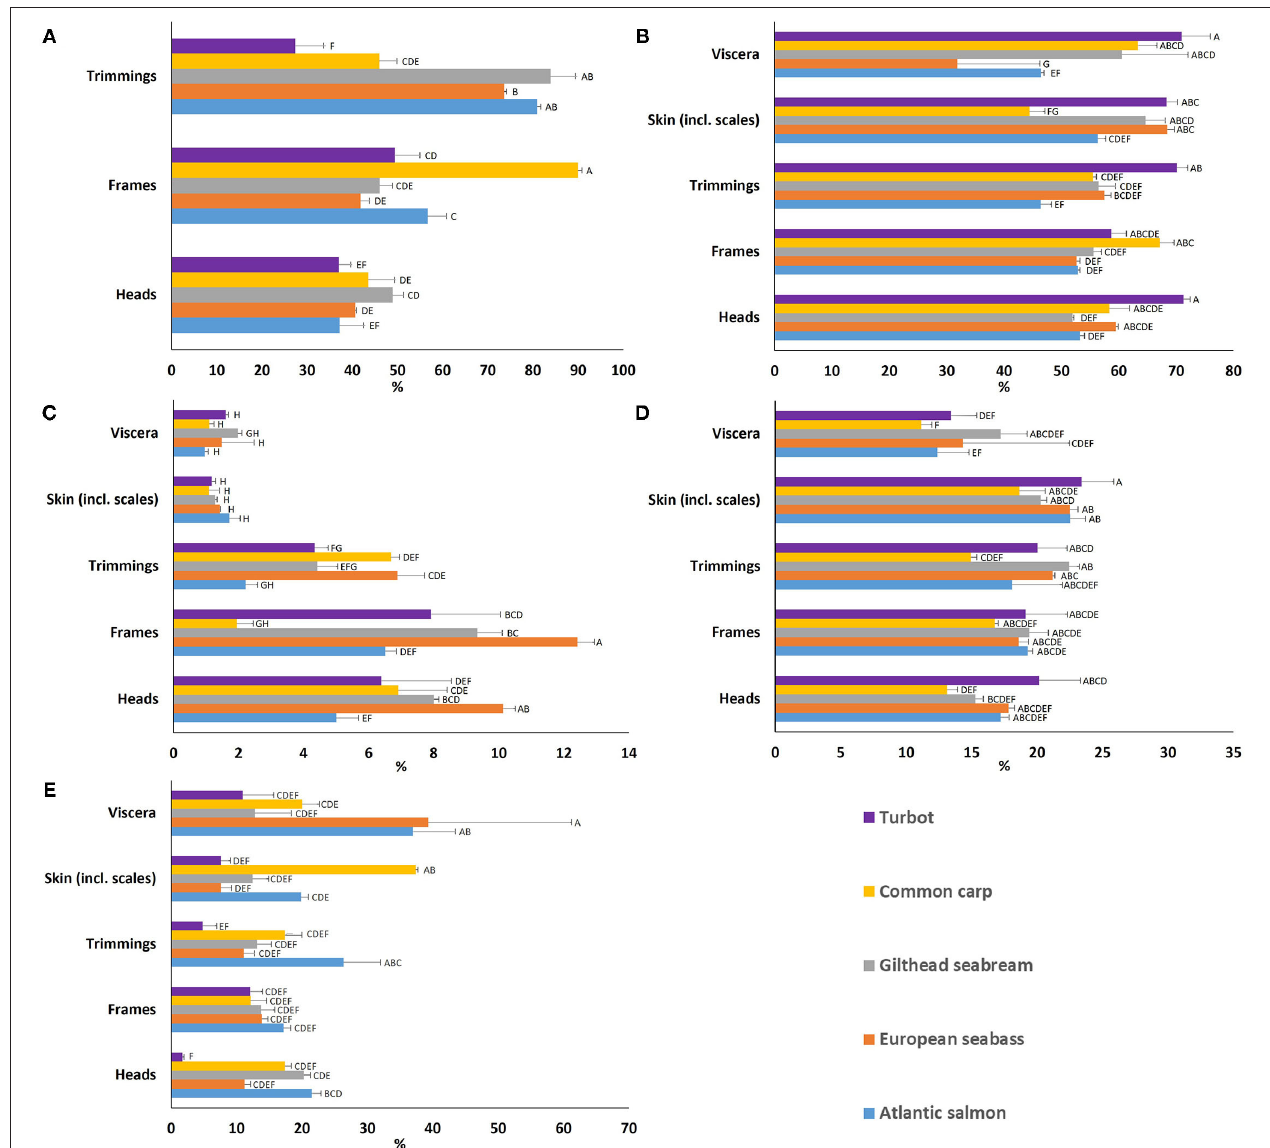
FIGURE 2 | (A) Edible yield and proximate composition (% of wet weight) [ (B) moisture, (C) ash, (D) crude protein, and (E) total lipid] of the various by-products [heads, frames, trimmings, skin (incl. scales), and viscera] for each of the European aquaculture species studied. Means that do not share letter(s) (A–H) are significantly